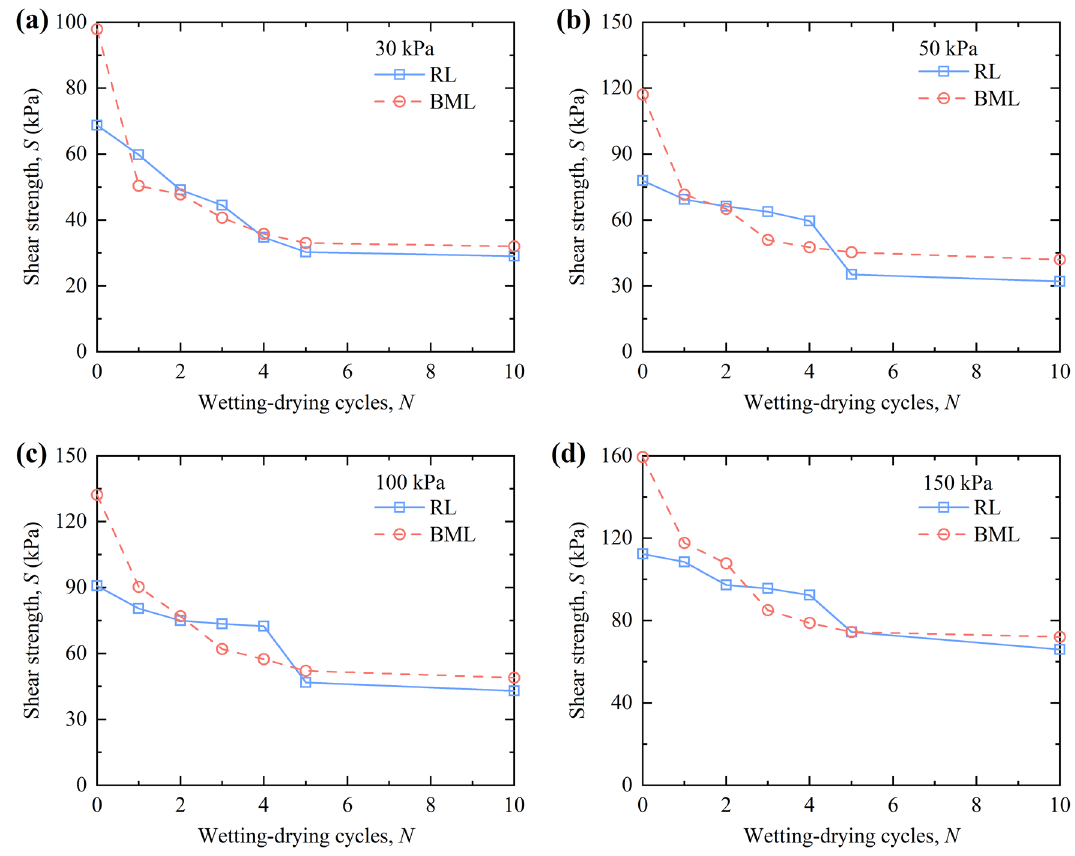
Figure 13. Shear strength curves of loess under W–D